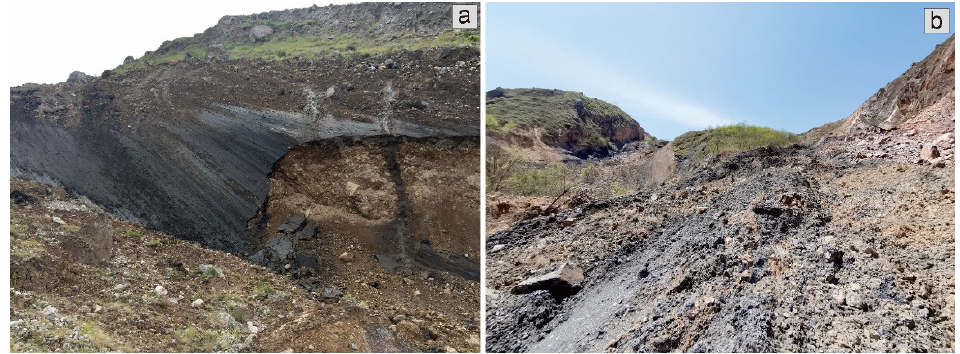
Figure 2. The black fault gouge distributed along the fault zone composing the sliding surface or landslide mass. ( a ) Jiangdingya landslide, ( b ) Yahuokou landslide. ( a ) Jiangdingya landslide, ( b ) Yahuokou